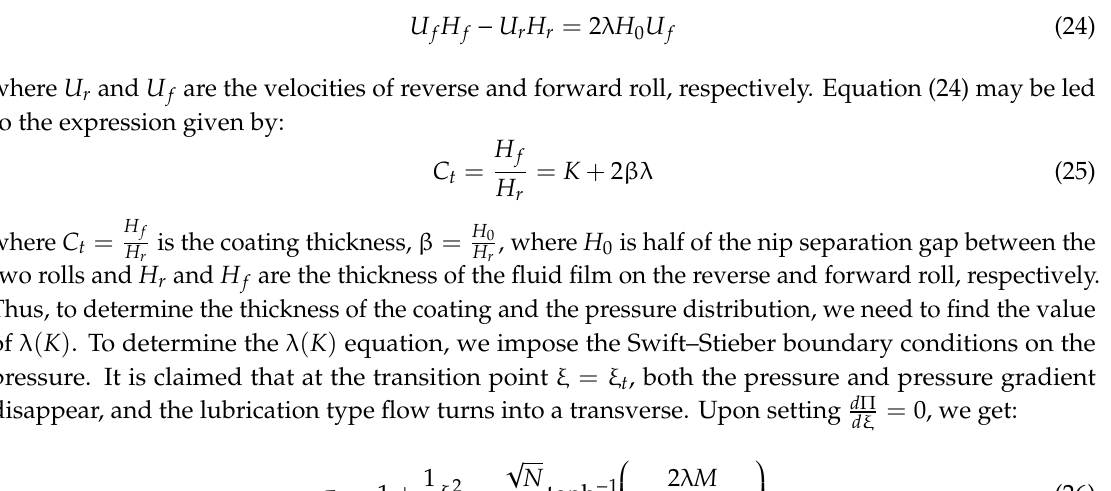
Table 1. E ff ect of K by fixing M = 0.2, ζ = 1, β = H 0